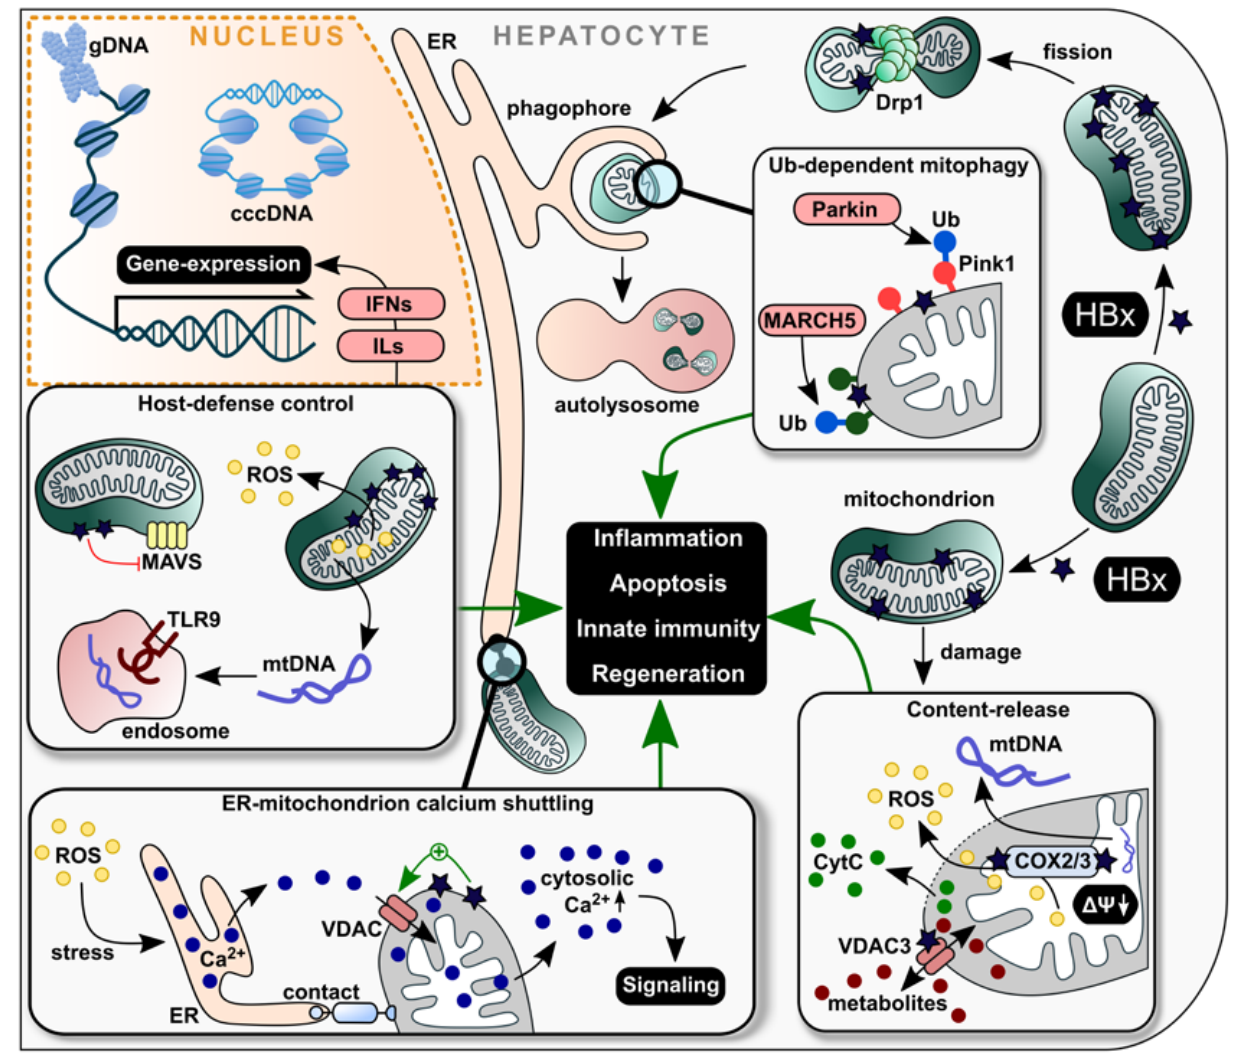
Figure 2. Schematic overview of HBx interaction with mitochondrial proteins in the context of liver pathology. HBx exerts fundamental effects on mitochondria themselves as well as on cellular processes linked to these organelles. Here, it modulates the mitochondrial morphology through Drp1 interaction towards fission, which leads to Ub-dependent mitophagy. At the OMM, interaction with both the ion channel VDAC3 and the redox chain proteins COX2/3 cause shifts in the mitochondrial membrane potential, followed by a release of CytC, ROS and mtDNA. This leads to an induction of apoptosis and inflammation. Furthermore, increased ROS levels induce ER stress and transport of Ca 2+ through the ER, the mitochondrion and, finally, into the cytosol, which elevates associated signaling pathways. On the side of host defense modulation, the interaction of HBx with MAVS downregulates the antiviral immune response and upregulates pro-inflammatory mediators such as IFNs and ILs. Further, the release of damaged mtDNA contributes to the activation of several signaling pathways and, in particular, to an activation of the TLR9 receptor. Ca 2+ , calcium ions; cccDNA, covalently closed circular DNA; COX2/3, cyclooxygenase 2/3; CytC, cytochrome complex C; Drp1, dynamin-related protein 1; ER, endoplasmic reticulum; gDNA, genomic DNA; IFN, interferon; IL, interleukin, MARCH5, membrane-associated RING-CH 5 protein, MAVS, mitochondrial antiviral signaling protein; mtDNA, mitochondrial DNA; PINK1, PTEN-induced kinase 1; ROS, reactive oxygen species, TLR9, toll-like receptor 9; Ub, ubiquitin; VDAC3, voltage-dependent anion